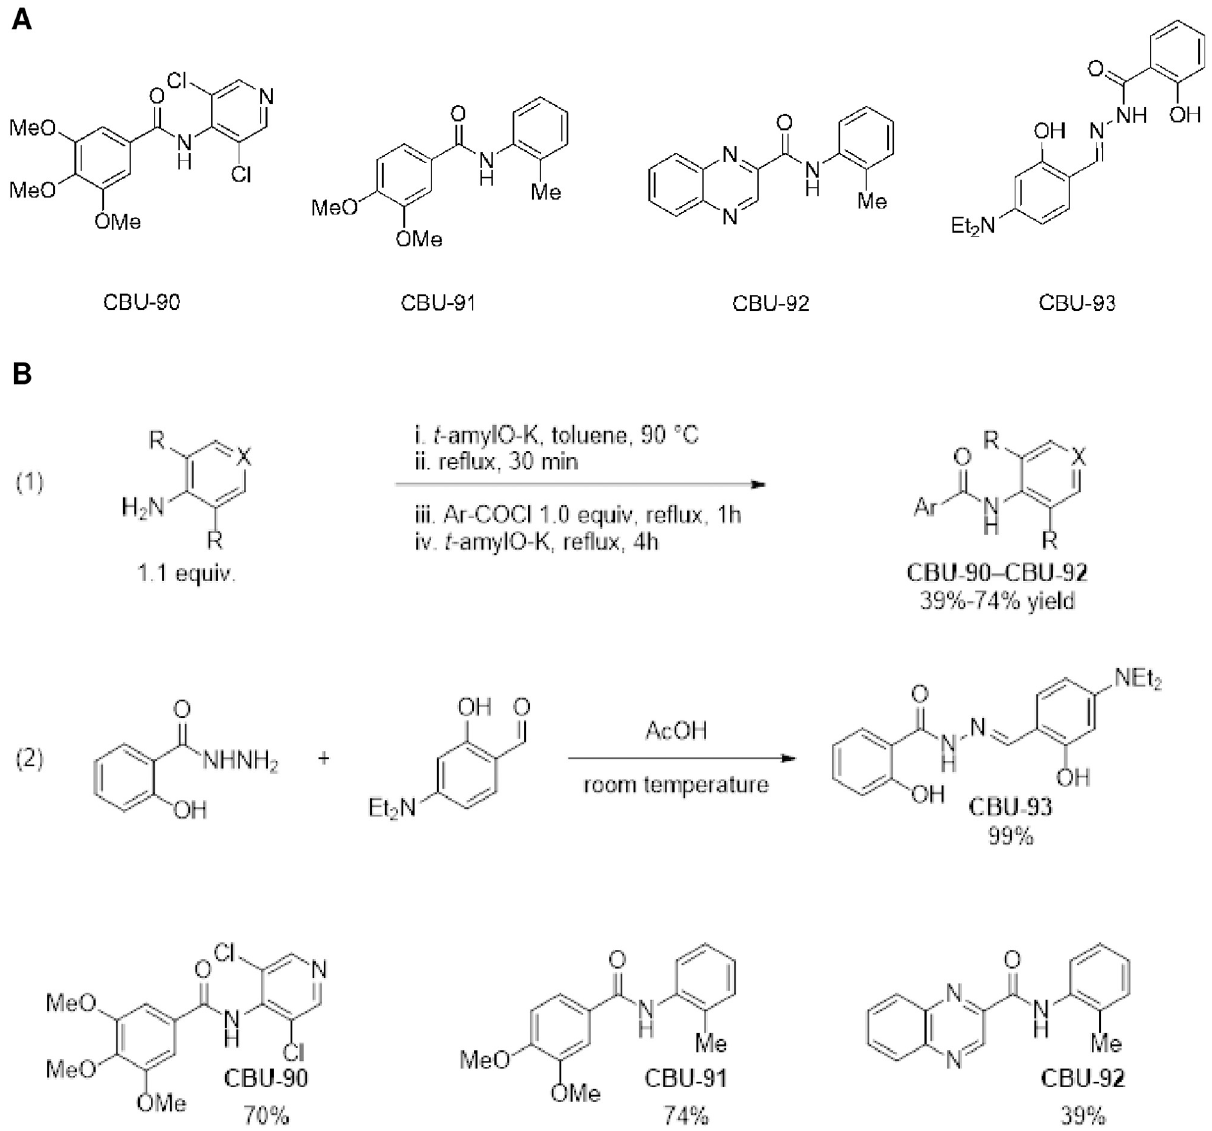
Fig 1. Initial group of small molecule inhibitors screened for activity against phosphodiesterases 1–5. A, Structure of CBU compounds (CBU90- 93). B, Synthetic route of CBU90-93.